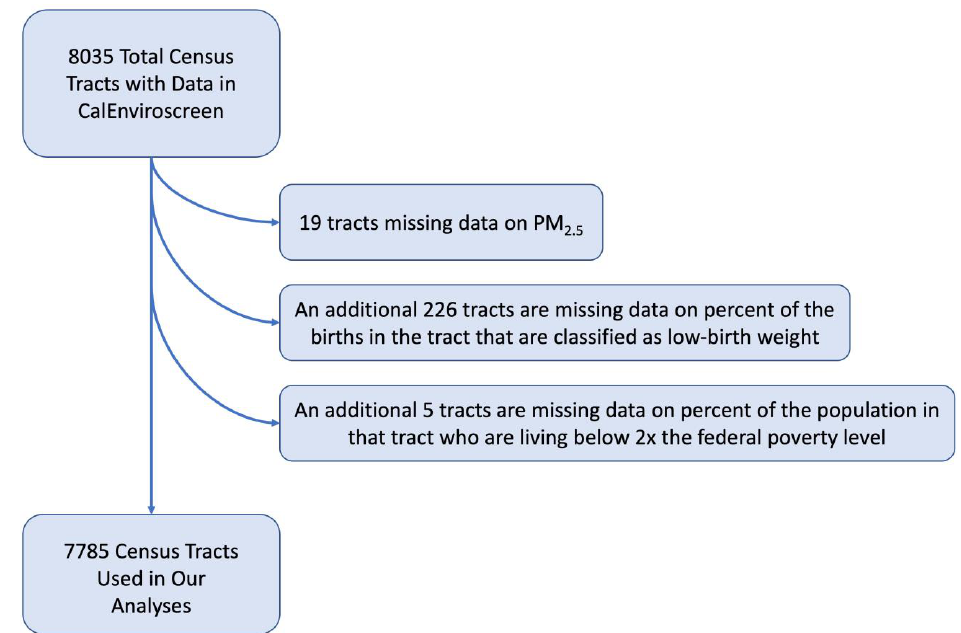
Figure 1. Flowchart demonstrating the selection of census tracts used in the analyses. 95